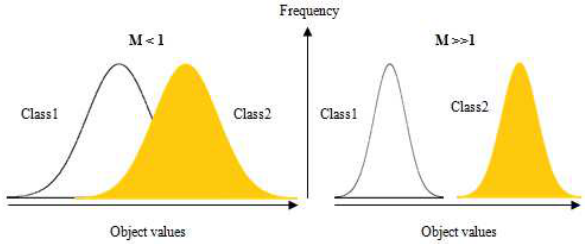
Figure 3. Illustration of the m-statistc group